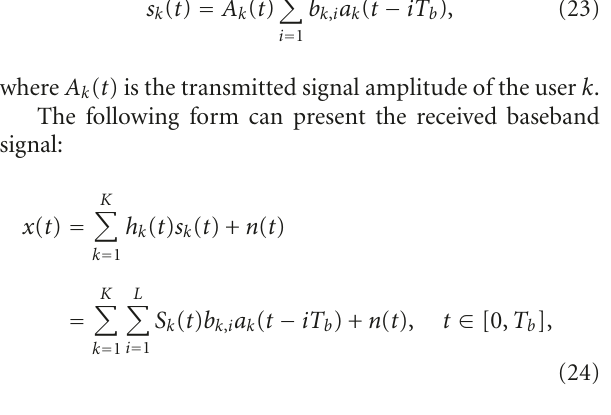
and noise can be appeared at the PF output and the only noise is existed at the AF output. It is well known, if a value of detuning between the AF and PF resonant frequencies is more than 4 ÷ 5 Δ f a , where Δ f a is the signal bandwidth, the processes forming at the AF and PF outputs can be considered as independent and uncorrelated processes (in practice, the coe ffi cient of correlation is not more than 0.05). statistical parameters at the AF and PF outputs will be the same, because the same noise is coming in at the AF and PF inputs, and we may think that the AF and PF do not change the statistical parameters of input process, since they are the linear GR front end systems. For this reason, the AF can be considered as a generator of reference sample with a priori information a “no” signal is obtained in the additional reference noise forming at the AF